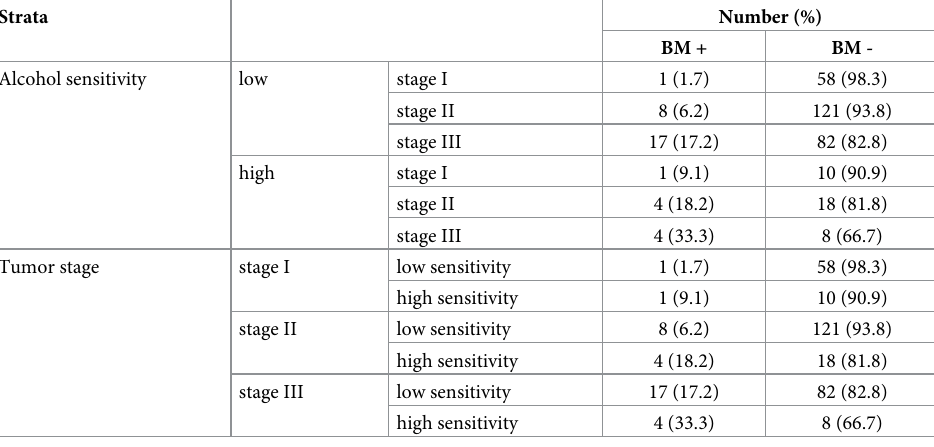
Table 2. Incidence of bone metastases stratified by alcohol sensitivity and tumor stages. Strata